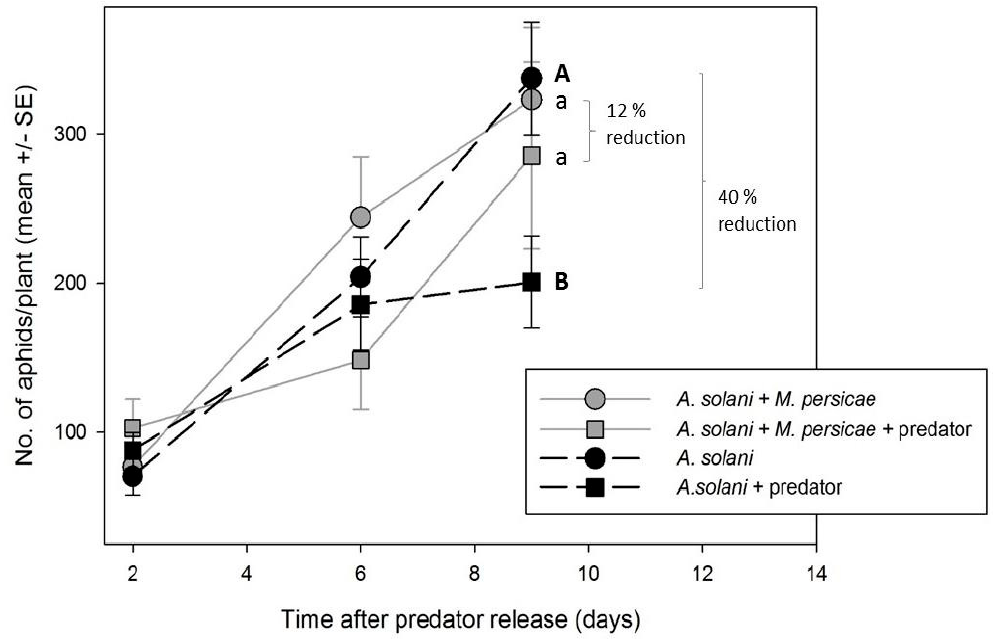
Figure 5. Mean number of A. solani per plant over time in the presence (square symbols) or absence (round symbols) of the predator Aphidolotes aphidimyza when presented alone or with a second, more preferred aphid species. Different letters indicate significant differences between treatments when M. persicae -infested plants are either present ( grey symbols) or absent ( black symbols). Statistical tests were conducted on log-transformed data, though arithmetic means and SEs are show.